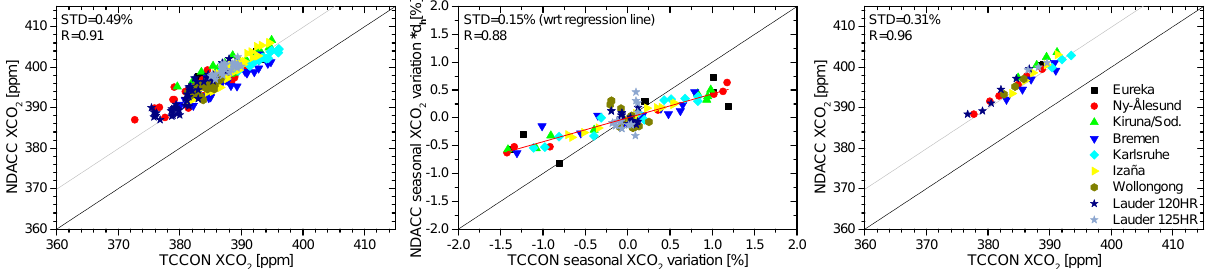
Figure 7. As Fig. 5 but for NDACC XCO 2 applying the fixed WACCM a priori. Left: monthly means, middle: detrended seasonal cycles with regression line (red), given standard deviation with respect to the regression line, right: de-seasonalised yearly means. The black line represents the one-to-one correlation, the grey line is the correlation shifted by 2.5%.